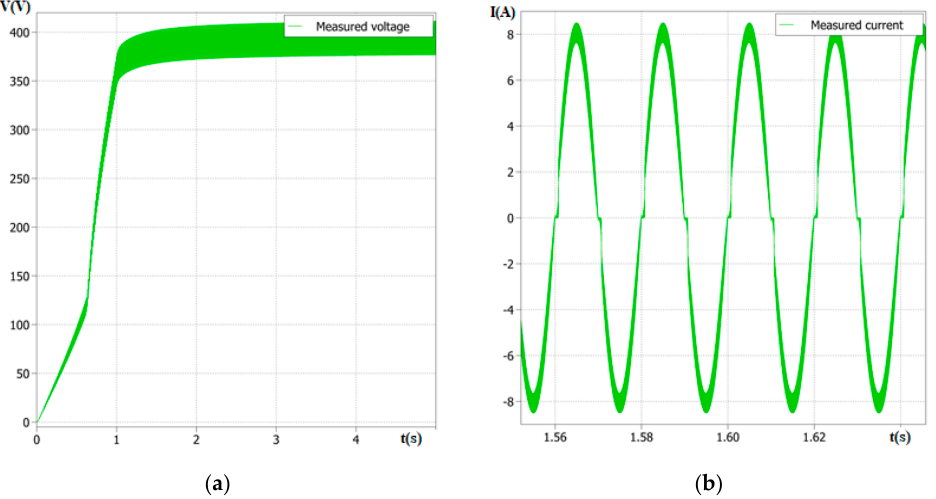
Figure 4. Waveforms obtained in simulation. ( a ) Output voltage, v o , and ( b ) input current, i L , in steady state.